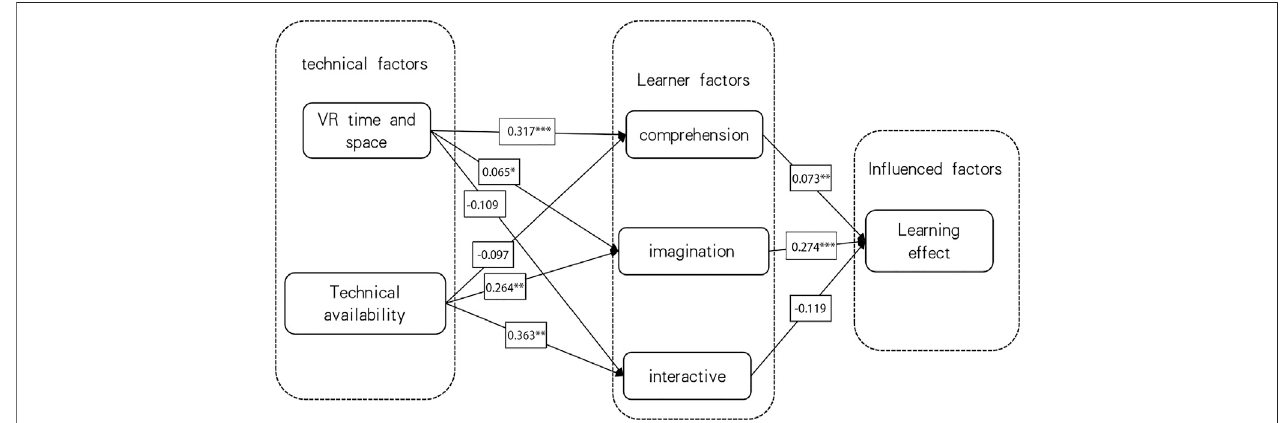
FIGURE 5 | Relationship model of VR time and space characteristics in fl uencing skill-based